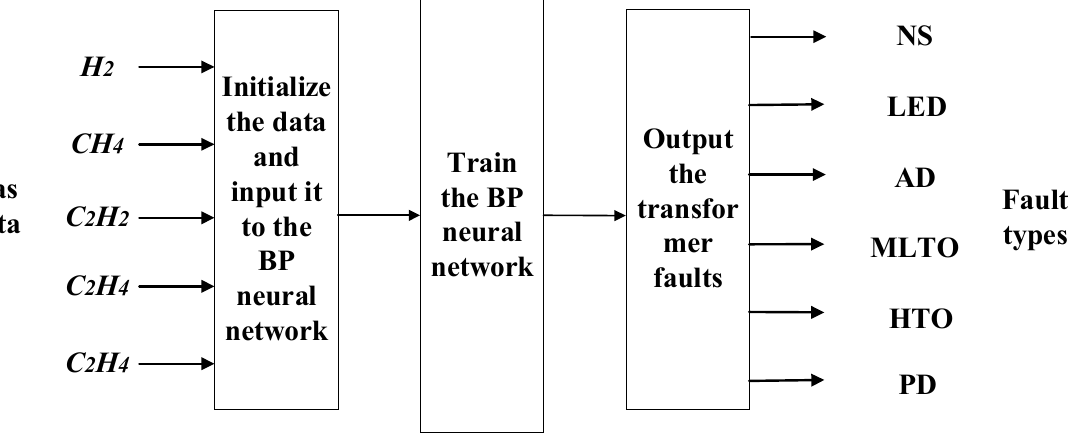
Figure 5. The transformer fault diagnosis model based on a BP neural network.